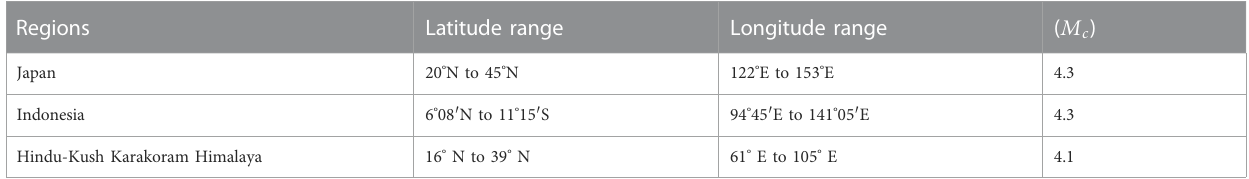
TABLE 1 Magnitude of completeness of earthquake catalogs and range of coordinate bounds considered for different regions.